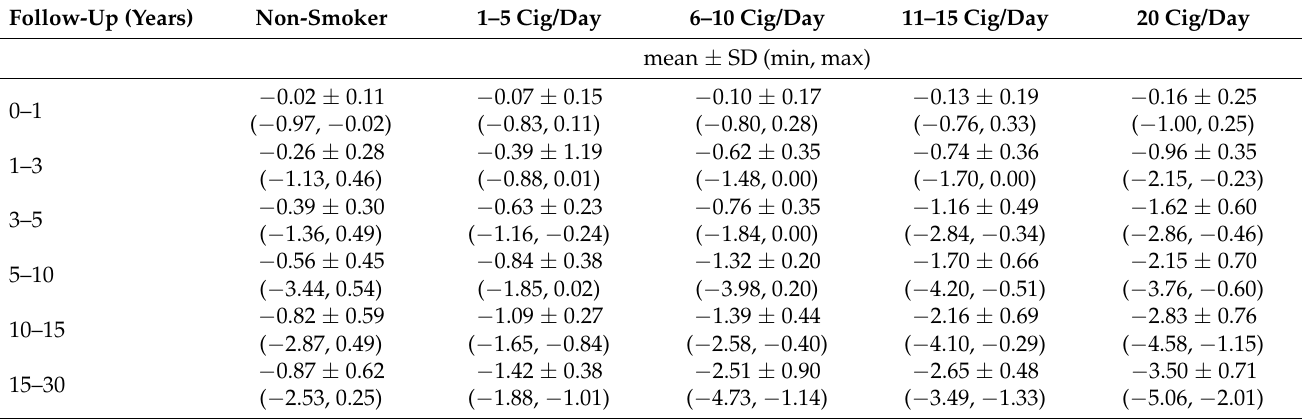
Table 2. Data on marginal bone loss distributed by different periods of follow-up, separated by dif- ferent frequencies of daily smoking. Values in millimeters. Negative values correspond to bone